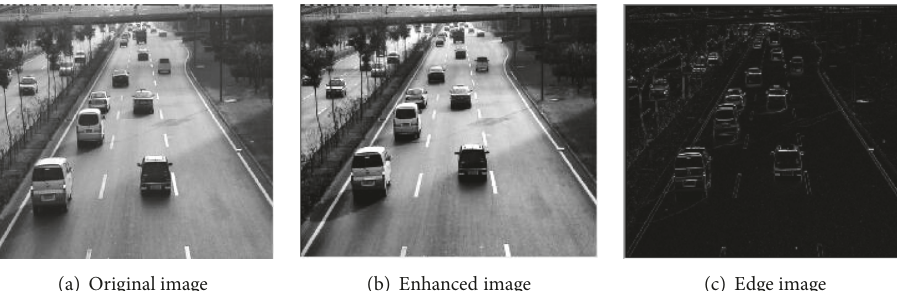
Figure 4: Image preprocessing.